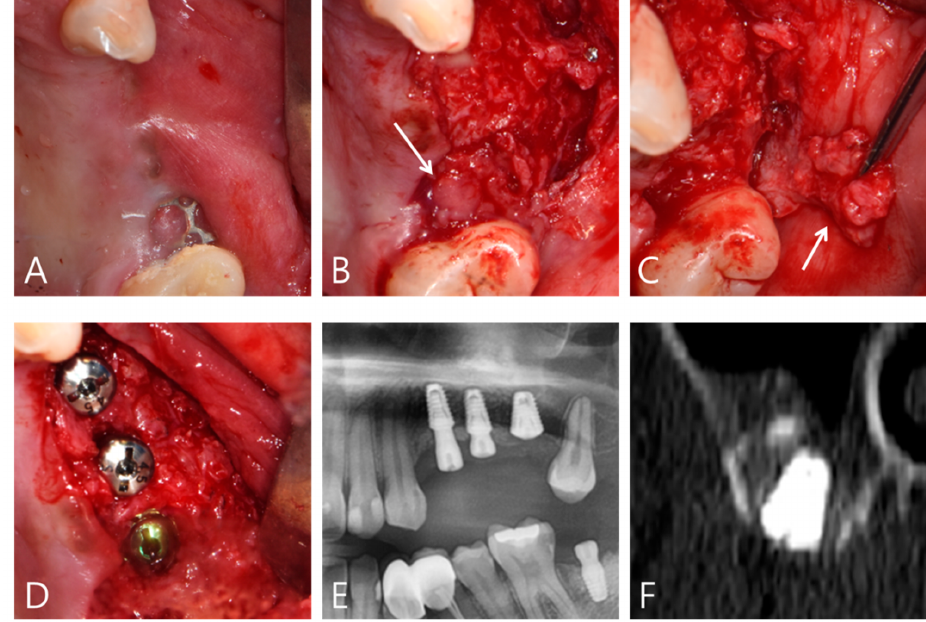
Figure 7. Clinical outcomes of the conservative treatment on case #3. ( A ) At 6 months after surgery, soft tissue remodeling was achieved while the titanium mesh was exposed. ( B ) After mesh removal, the dehiscence area showed soft-tissue growth (arrow) under the titanium mesh. ( C ) The soft tissue was connected to the buccal gingiva (arrow). ( D ) The implants were placed with the removal of the titanium mesh on patient #3. ( E , F ) The dental implant could be placed stably on the dehiscence area at 6 months after the graft.